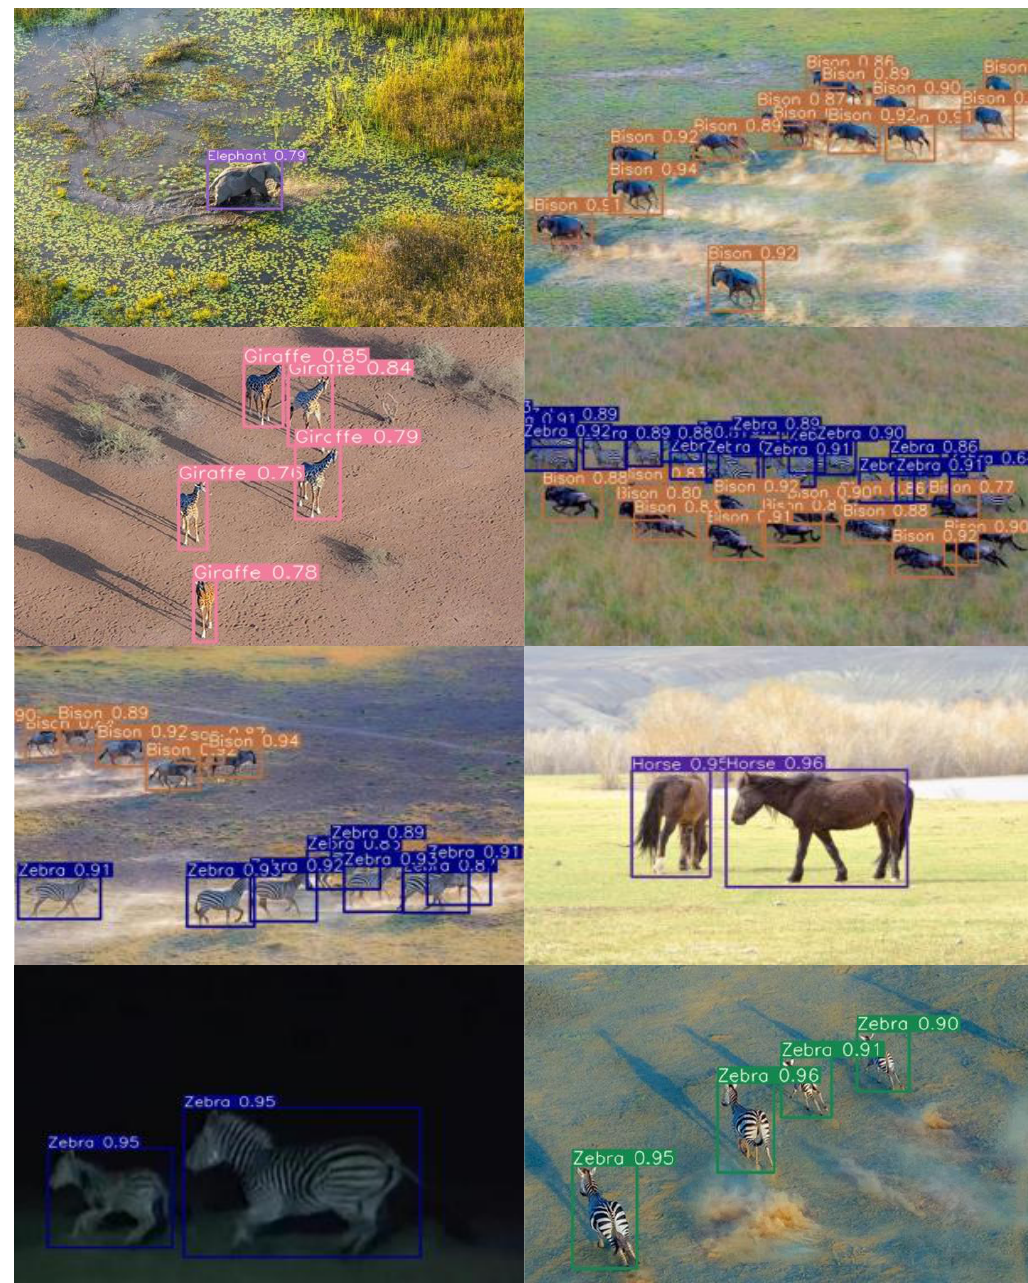
Figure 11. Grassland animal test results.